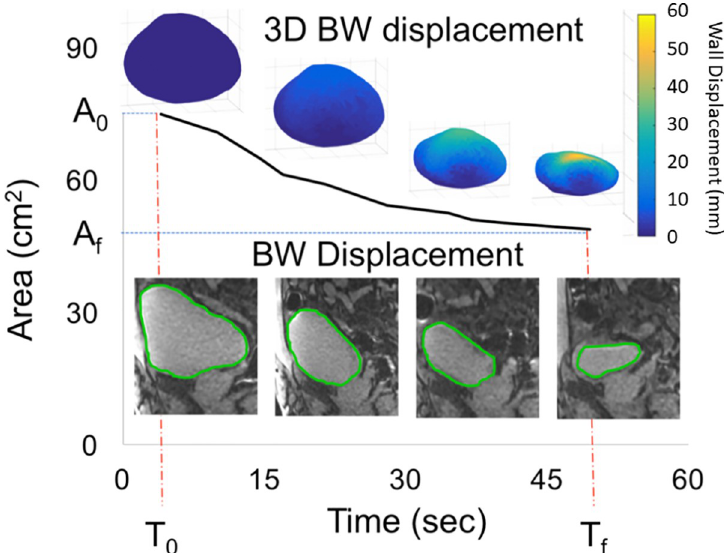
Fig 3. Real time imaging of voiding in a 66-year-old healthy volunteer. The curve shows the bladder emptying with respect to time following a sigmoidal behavior. 2D mid sagittal plane images show the bladder deformation at four different time points during the voiding event. Similarly, three-dimensional (3D) maps show bladder contraction (wall displacement) estimated from computational interpolation between pre and post void MRI at four different time points during voiding.